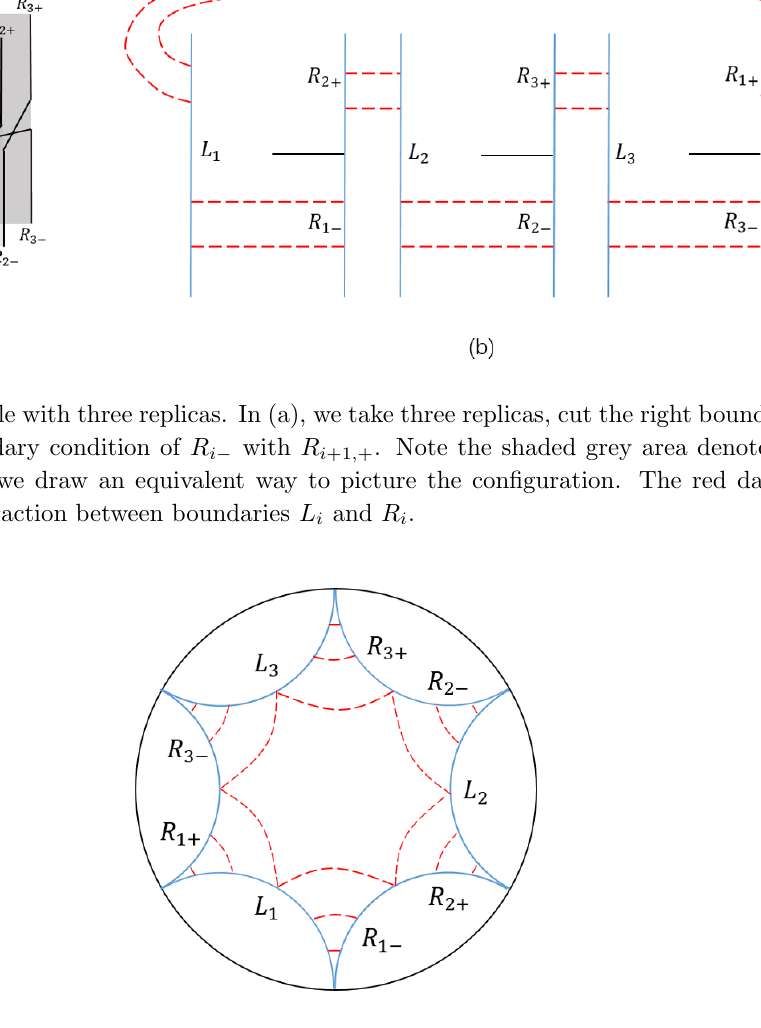
Figure 4 . We place the system with three replicas on the Hyperbolic disk. The red dashed lines denote the coupling between the